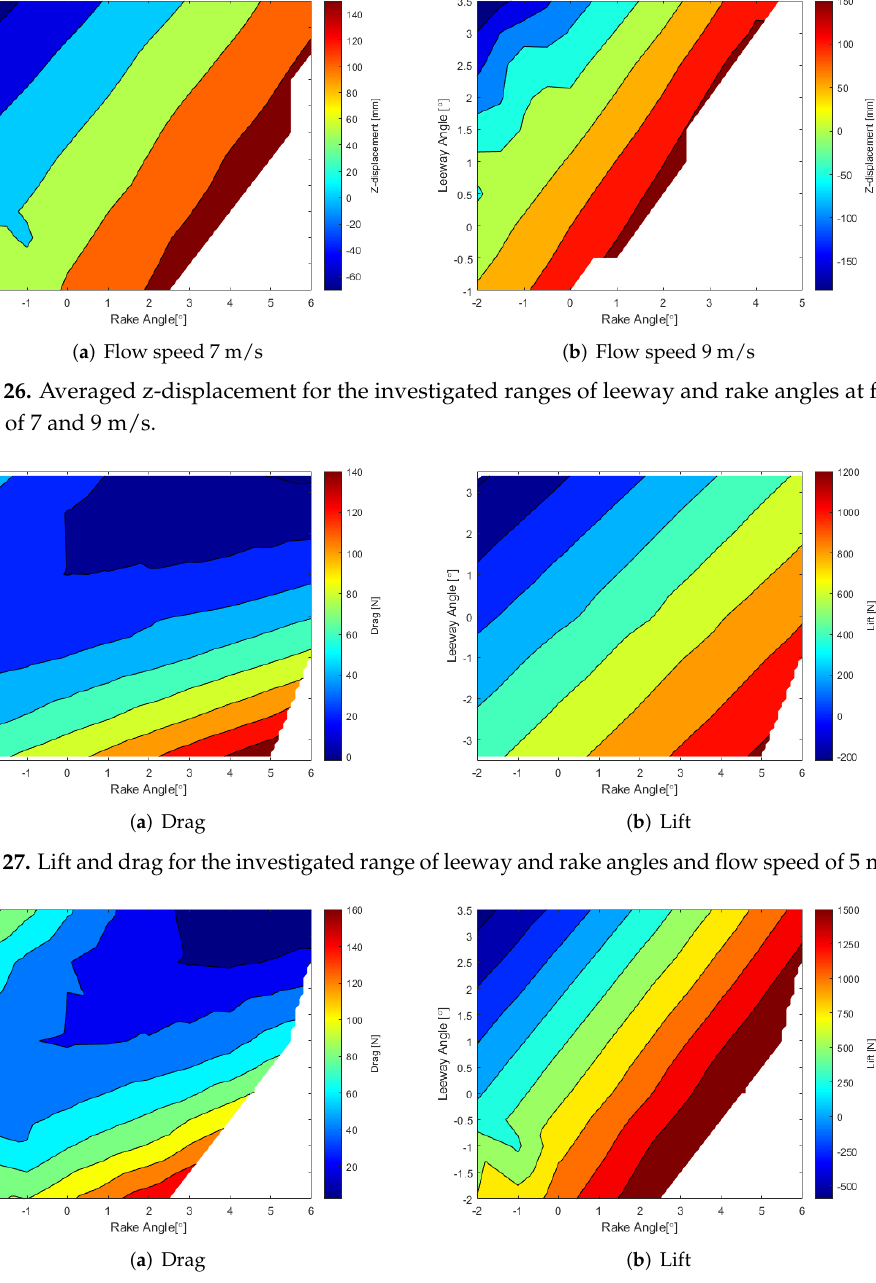
Figure 28. Lift and drag for the investigated range of leeway and rake angles and flow speed of 7